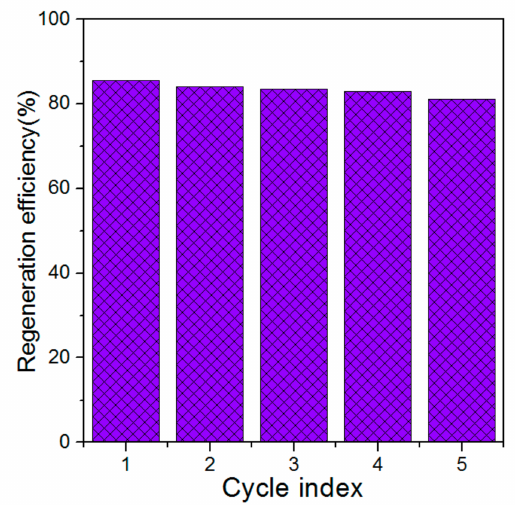
Figure 4. The regeneration efficiencies of resins after DBD plasma multiple cycles.